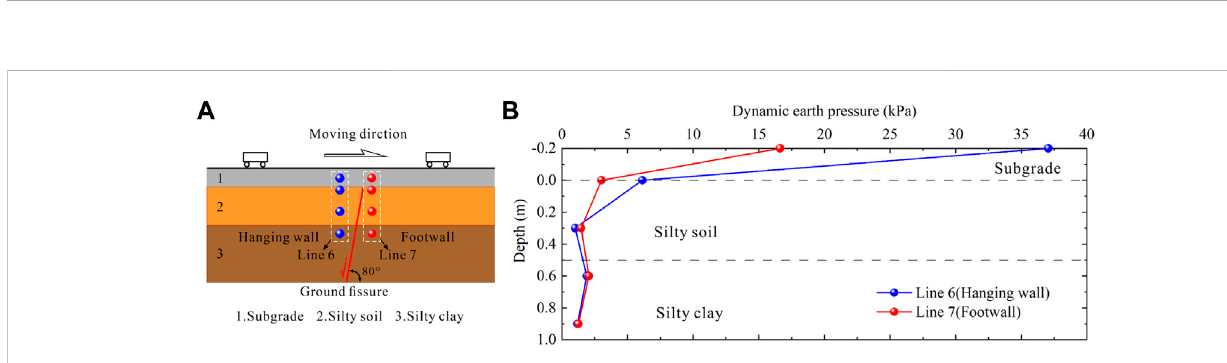
According to the acceleration-time curves of silty soil (stratum 2) and silty clay (stratum 3) inside the foundation (Line 6 and Line 7), the curves of foundation peak acceleration in the hanging wall and footwall of the ground fi ssure along the depth were drawn (Figure 13B). Figures 13C, D show the curves of dynamic velocity and dynamic displacement along the depth obtained from acceleration through the SeismoSignal software. The velocity and displacement of a signal can be obtained by directly integrating the acceleration signal in time domain using the following de fi